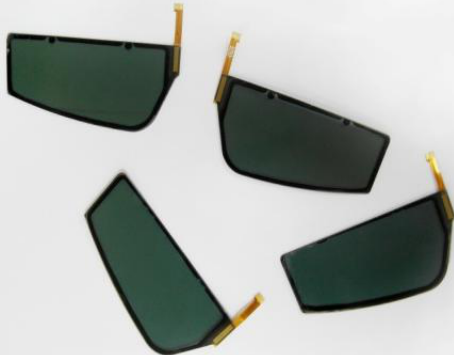
Figure 5. Examples of the fabricated flexible liquid crystal